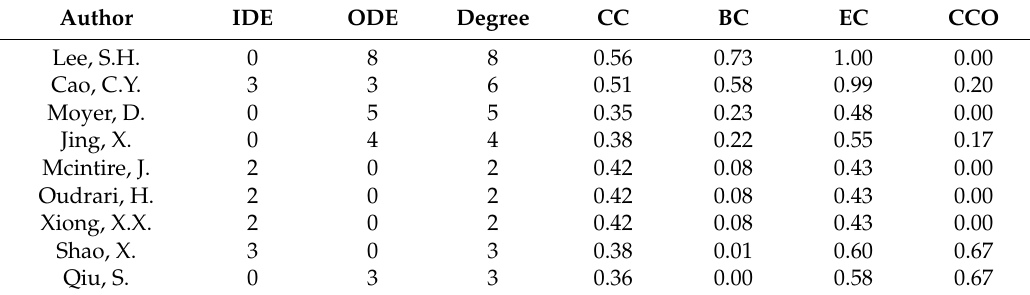
Table 5. Leading authors in the Lee SH–Cao CY research community by BC rankings.